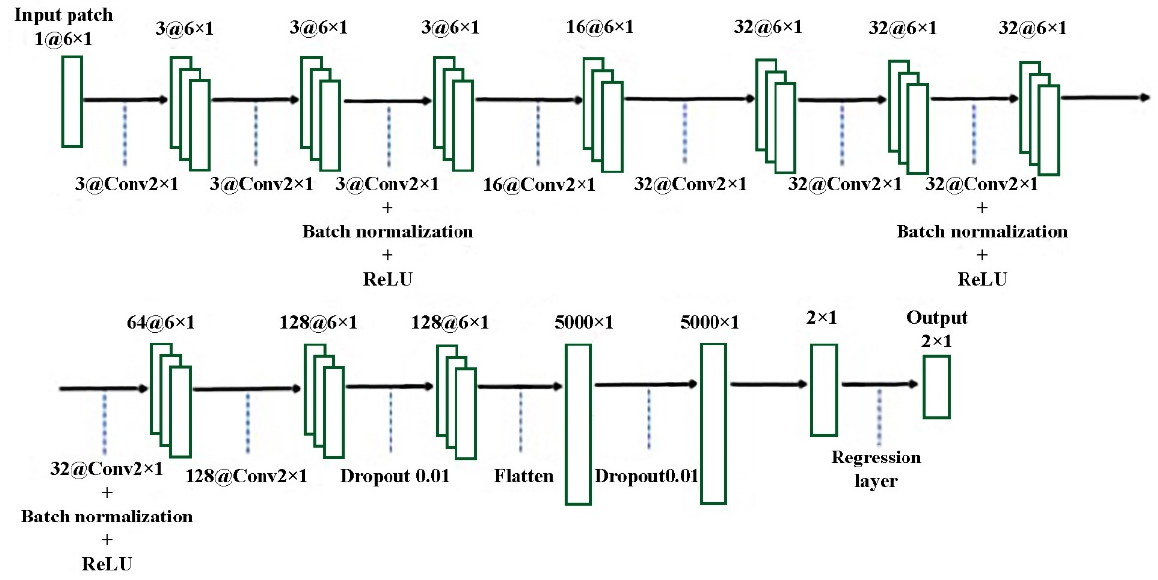
Figure 3. Our implemented convolutional neural network (CNN) model.